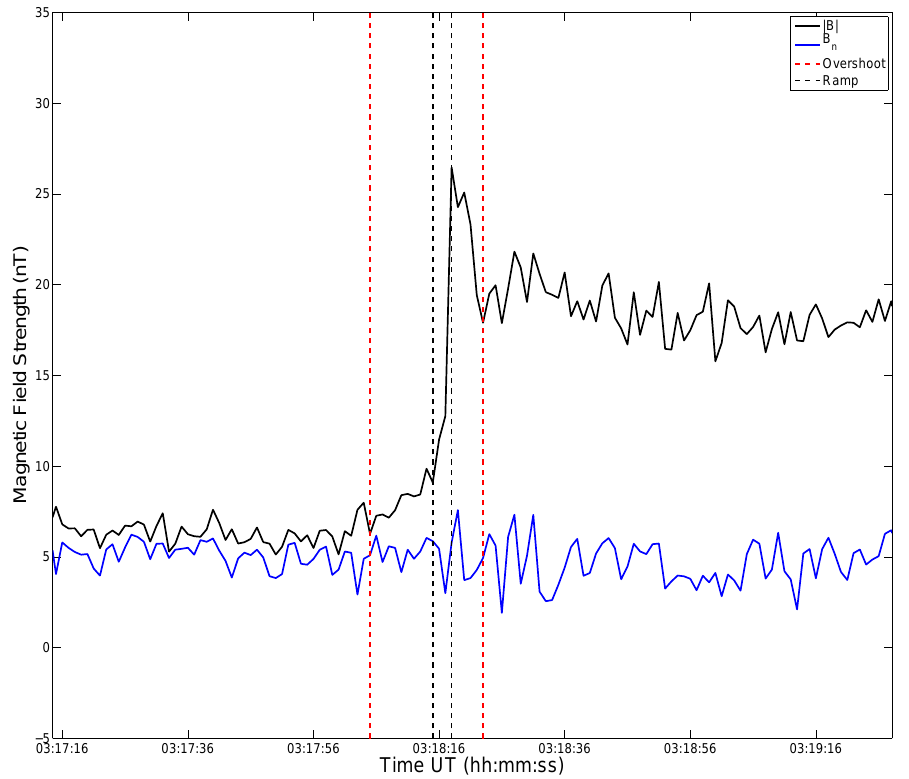
Fig. 1. A crossing of the Venusian bow shock on 24 April 2008. The black line shows the magnetic field profile measured by the VEX MAG instrument. The blue plot shows the magnetic field directed along the shock normal. Two red dashed lines show the interval of the magnetic overshoot used to determine the shock spatial